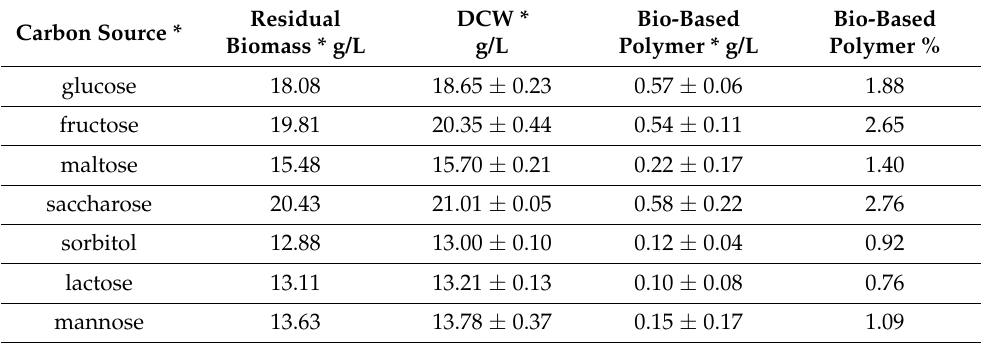
Table 2. Use of different carbon sources for the extraction of the bio-based polymer.